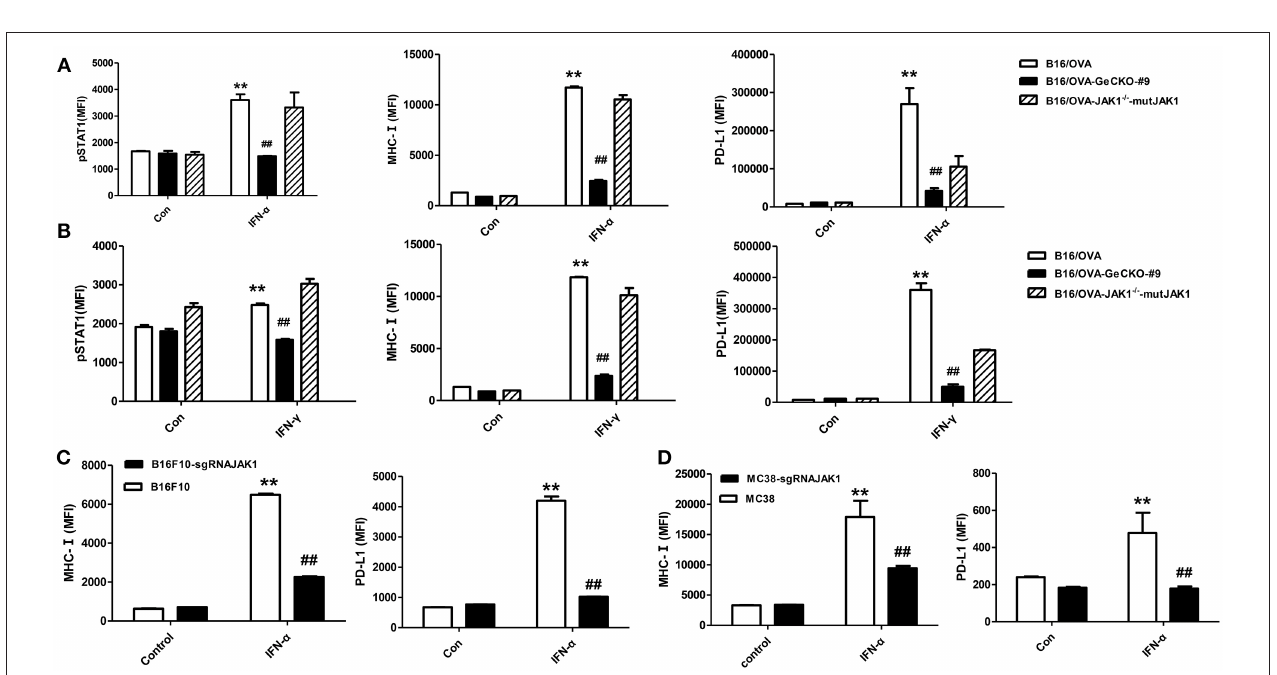
FIGURE 2 | Loss of JAK1 attenuates JAK–STAT signaling in tumor cells. (A,B) B16/OVA, B16/OVA-JAK1 − / − , and B16/OVA-JAK1 − / − -mutJAK1 were stimulated with mouse (m)IFN- γ (100ng/mL) (A) or mIFN- α 4 (500ng/mL) (B) , and pSTAT1 level was analyzed by flow cytometery 0.5h later. MHC-I and PD-L1 expression was analyzed by flow cytometry 24h after stimulation. MHC-I and PD-L1 expression in B16F10 and MC38 cells with JAK1 deficiency were observed after stimulation with mIFN- α 4 (500ng/mL) (C,D) . Data are presented as mean ± SEM. ** P < 0.01 vs. B16- OVA/B16F10/MC38 control group; ## P < 0.01 vs. B16/OVA/B16F10/MC38 + IFN- α group.